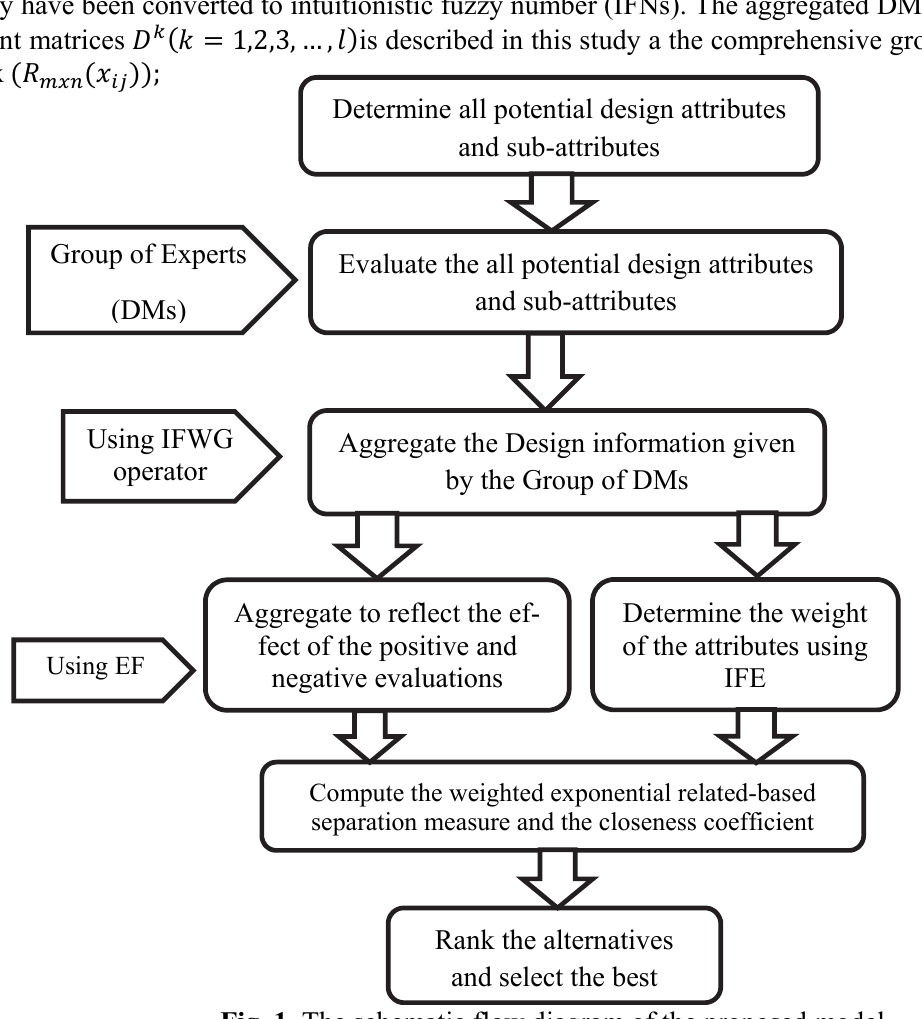
Fig. 1. The schematic flow diagram of the proposed